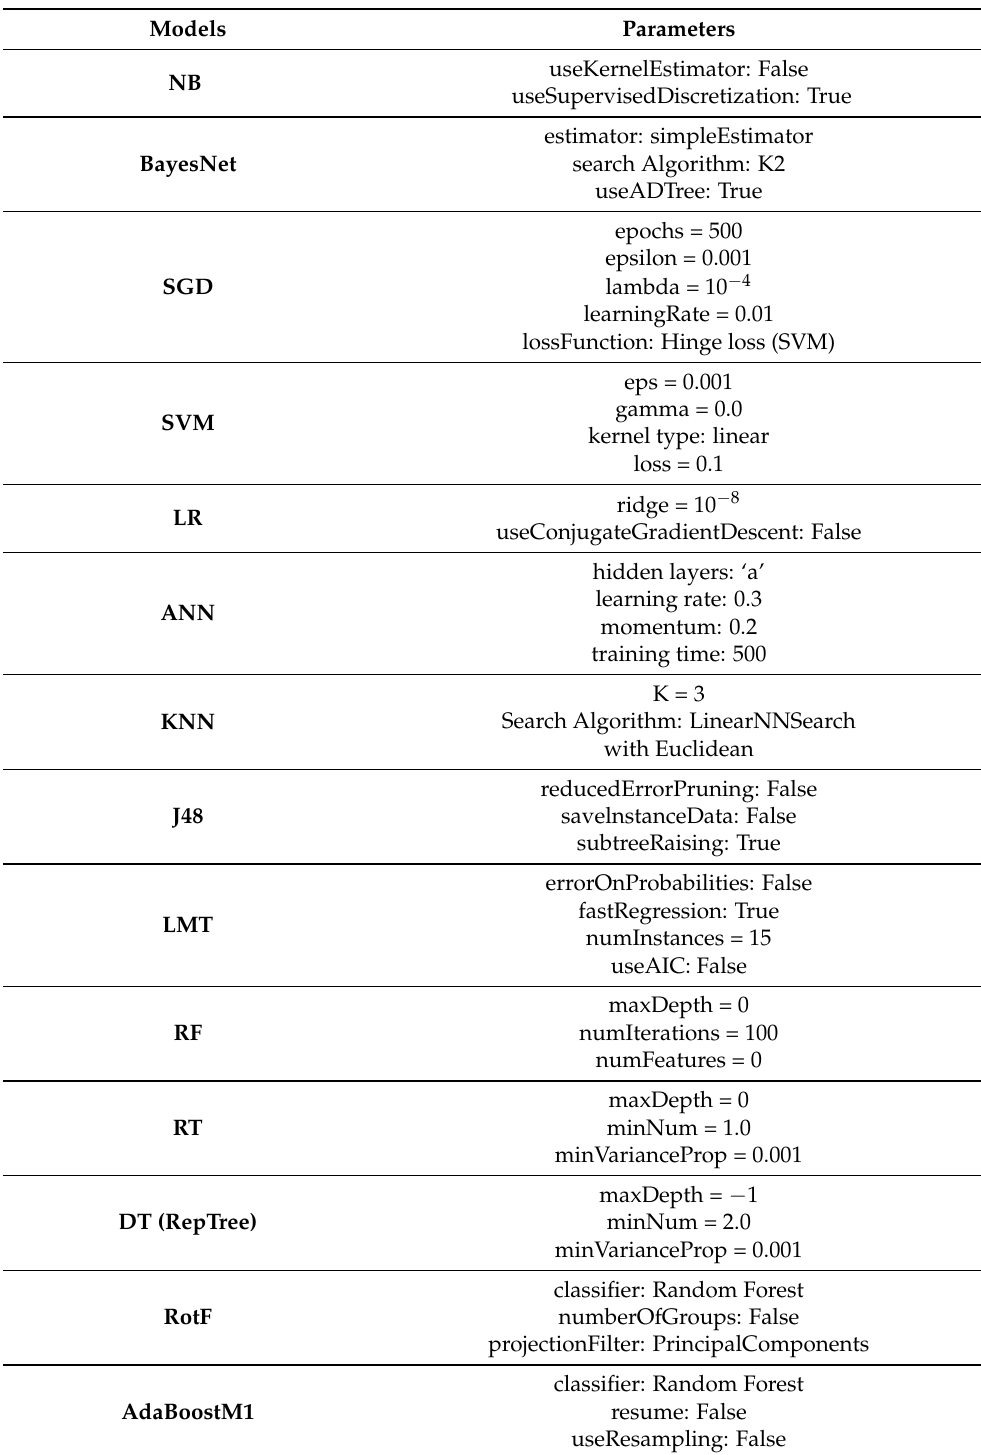
Table 3. Machine learning models’